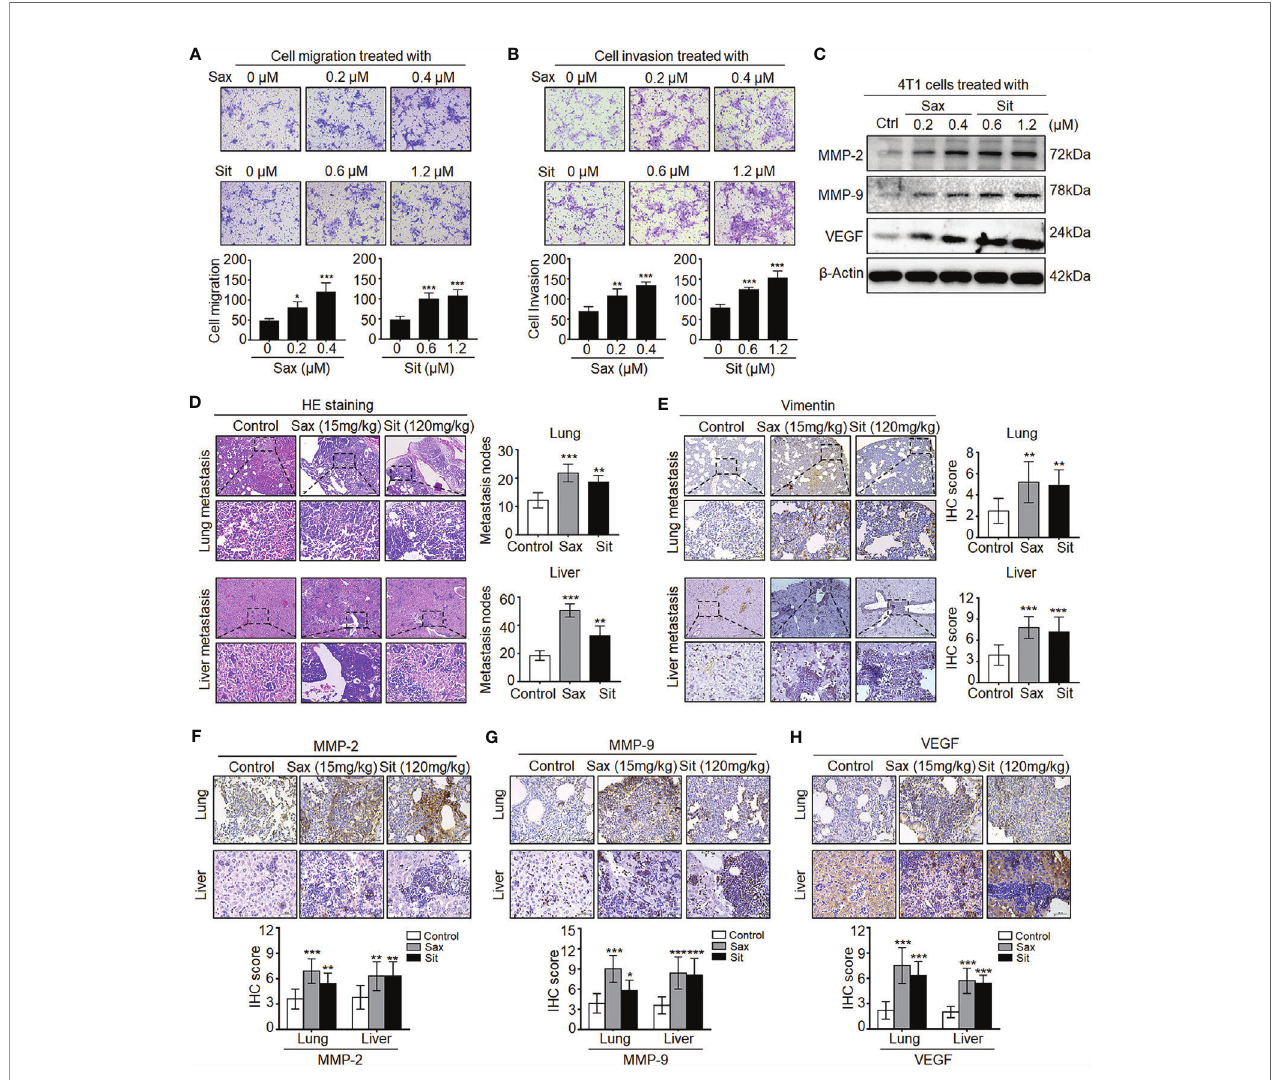
FIGURE 1 | DPP-4i (Sax and Sit) promotes murine breast cancer metastasis in immune-competent BALB/c mice. (A, B) DPP-4i (Sax and Sit) facilitates BC cells metastasis in vitro . The metastatic ability of 4T1 cells was evaluated by (A) cell migration and (B) cell invasion assays upon treatment of Sax (0, 0.2, and 0.4 m M) or Sit (0, 0.6, and 1.2 m M) for 24 h. Migration or invasion cells were counted in 5 – 10 random fi elds (200× magni fi cation). (C) DPP-4i increases metastasis-associated gene levels. Metastasis-associated MMP-2, MMP-9 and VEGF levels were detected by Western blotting in DPP-4i-treated 4T1 cells. b -Actin gene was as a loading control. (D, E) DPP-4i accelerates BC lung and liver metastasis in vivo . 4T1 cells (1.0 × 10 5 ) in 100 m l PBS buffer were injected into in the left mammary fat pad of female BALB/c mice. Postinjection 3 – 5 days, mice were randomly allocated to three groups (n = 3 – 5 mice/group) and then treated with 0.9% NaCl (control), Sax (15 mg/kg), or Sit (120 mg/kg) via oral gavage daily. After 2 weeks, lung and liver tissues were collected, and metastatic nodes were analyzed by (D) H&E staining and (E) IHC staining for vimentin. (F – H) DPP-4i enhances metastasis-associated gene expression in vivo . MMP-9, MMP-2, and VEGF were detected by IHC staining in lung and liver metastatic tissues. Data are presented as mean ± SD of three independent experiments. Representative images are shown. Scale bar: 200 m m (low magni fi cation); 50 m m (high magni fi cation). *p < 0.05, **p < 0.01, and ***p < 0.001 between the indicated groups determined by the one-way analysis of variance